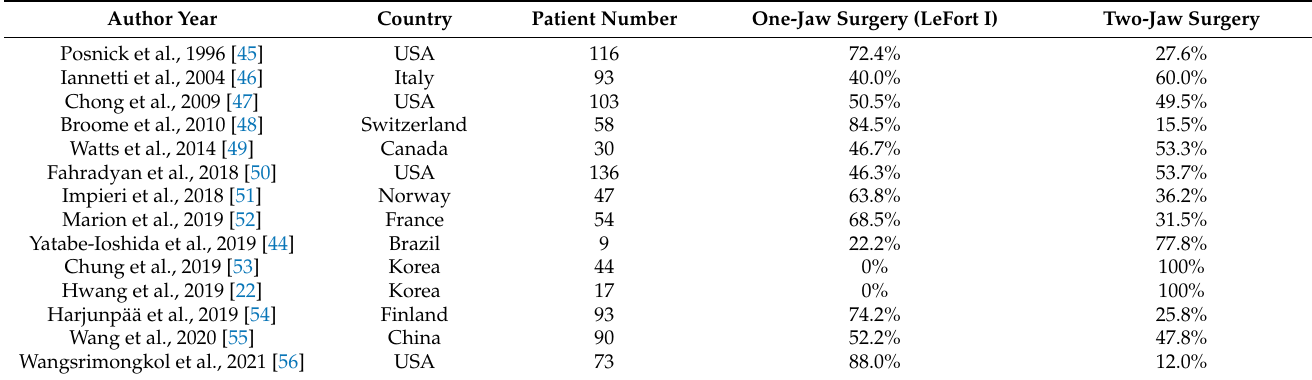
Table 6. The incidence of one-jaw and two-jaw cleft orthognathic surgery in different